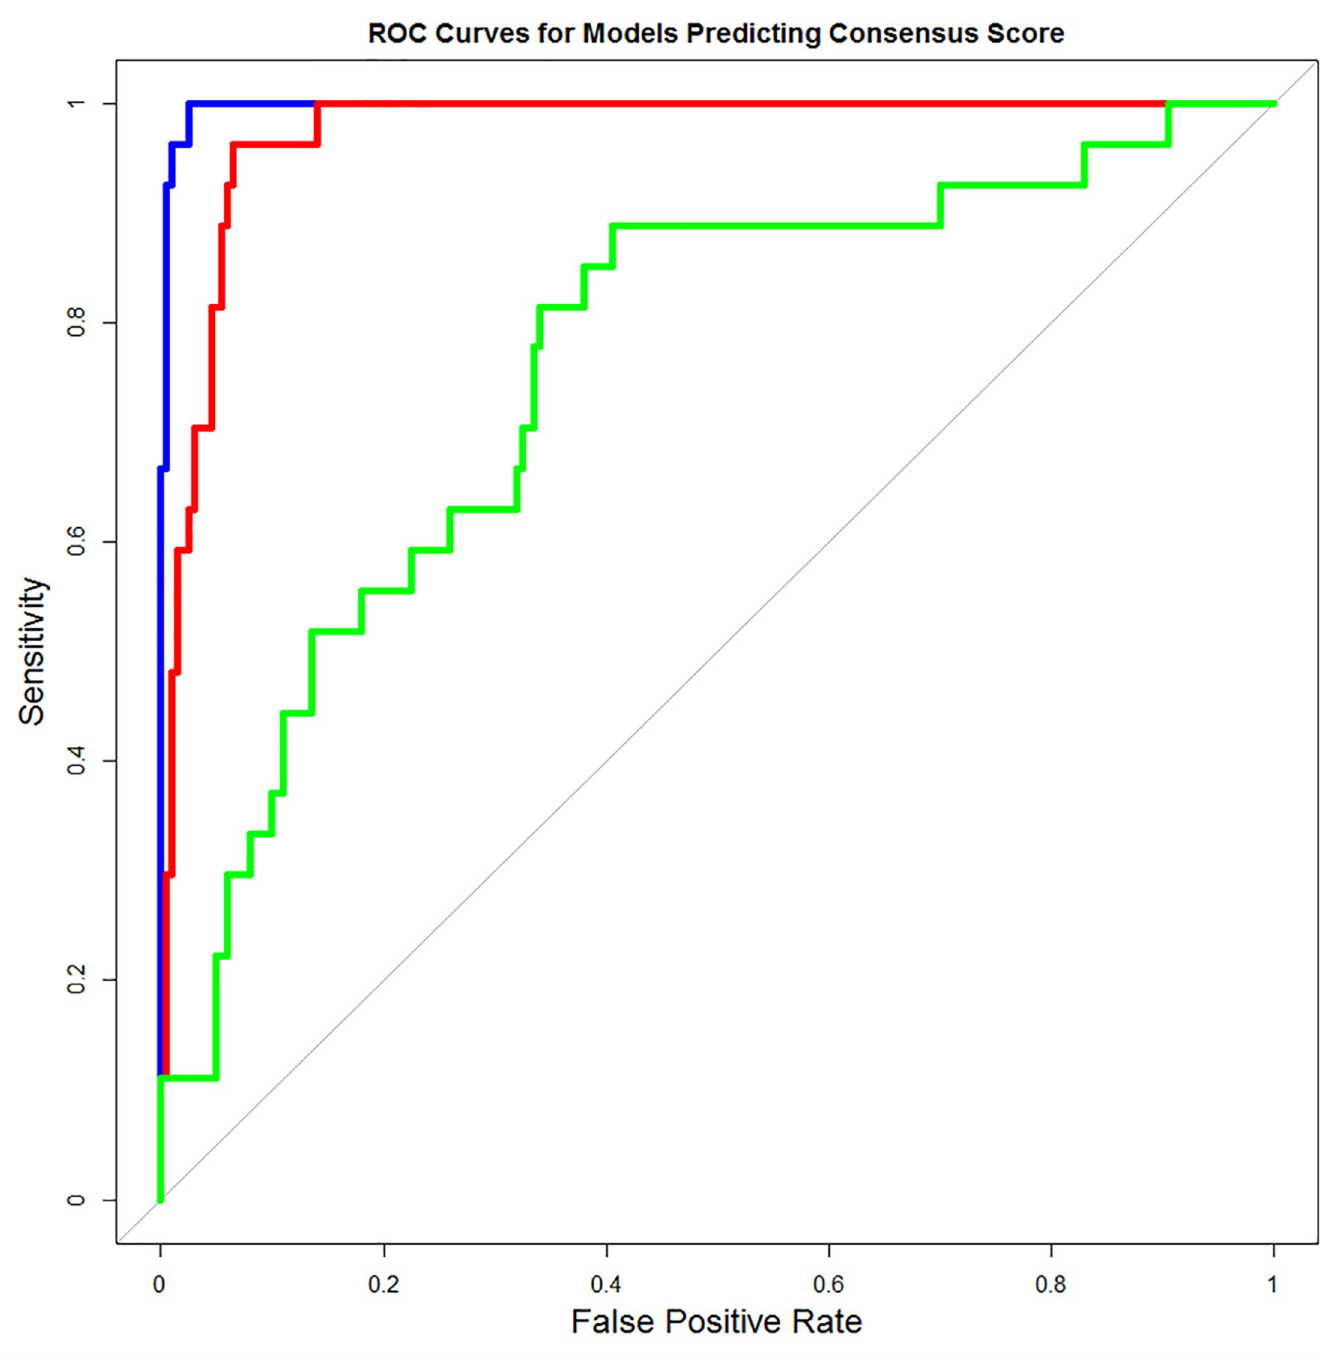
Fig 3. Ramachandran plot of complete model. This model shows the number of residues in the favored, allowed and outlier region. As mostly glycine has two hydrogen atoms attached to its side chain so if it lies in outlier region, it does not affect the overall 3D structure. with alanine was also predicted deleterious by our study. Asp366 forms a hydrogen bond with Pro348, and when we replaced Asp366 with alanine, it caused breakage in hydrogen bonds with Pro348 Fig 4.